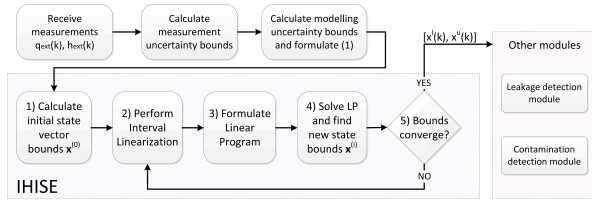
Figure 1. A diagram illustrating how the IHISE algorithm works in a real-time